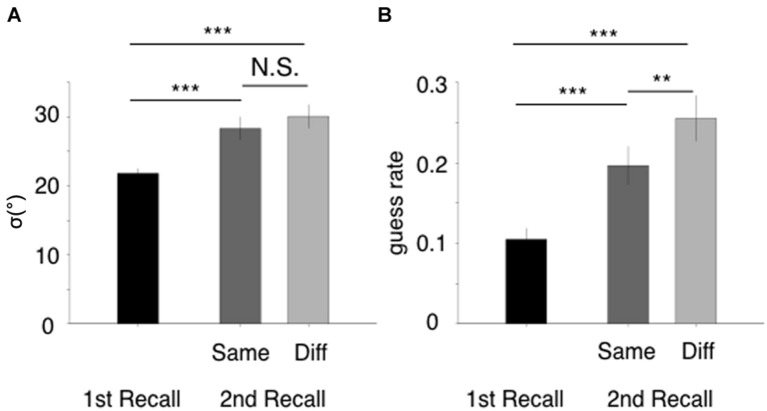
Results of Experiment 1. (A) Estimated standard deviations from the first recall task (black), the second recall task’s same-group condition (dark gray), and the second recall task’s different-group condition (light gray). ±1 SE are used for the error bars. Statistical significance levels obtained from pairwise comparisons are represented as N.S. for p > 0.1, ∗p < 0.05, ∗∗p < 0.01, ∗∗∗p < 0.001. (B) Estimated guess rates for the three conditions. The measurement and analysis aspects are the same as those presented for (A).